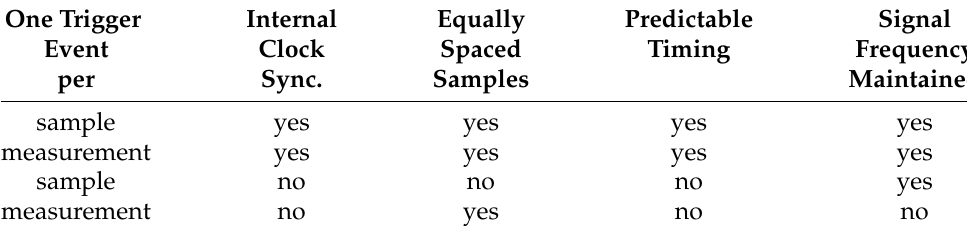
Table 3. Comparison of voltmeter triggering